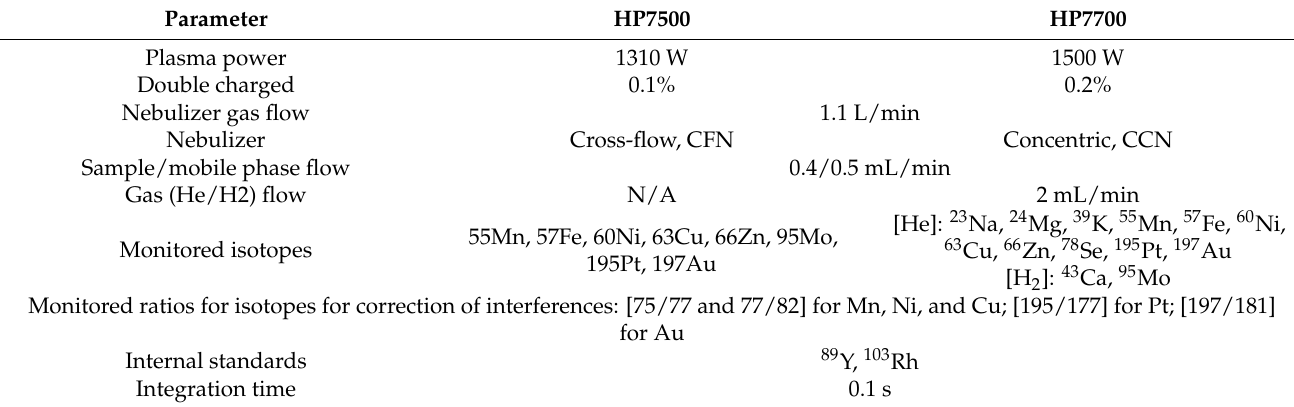
Table 3. Optimal parameters for metal determination by two ICP-MS instruments (HP7500 and